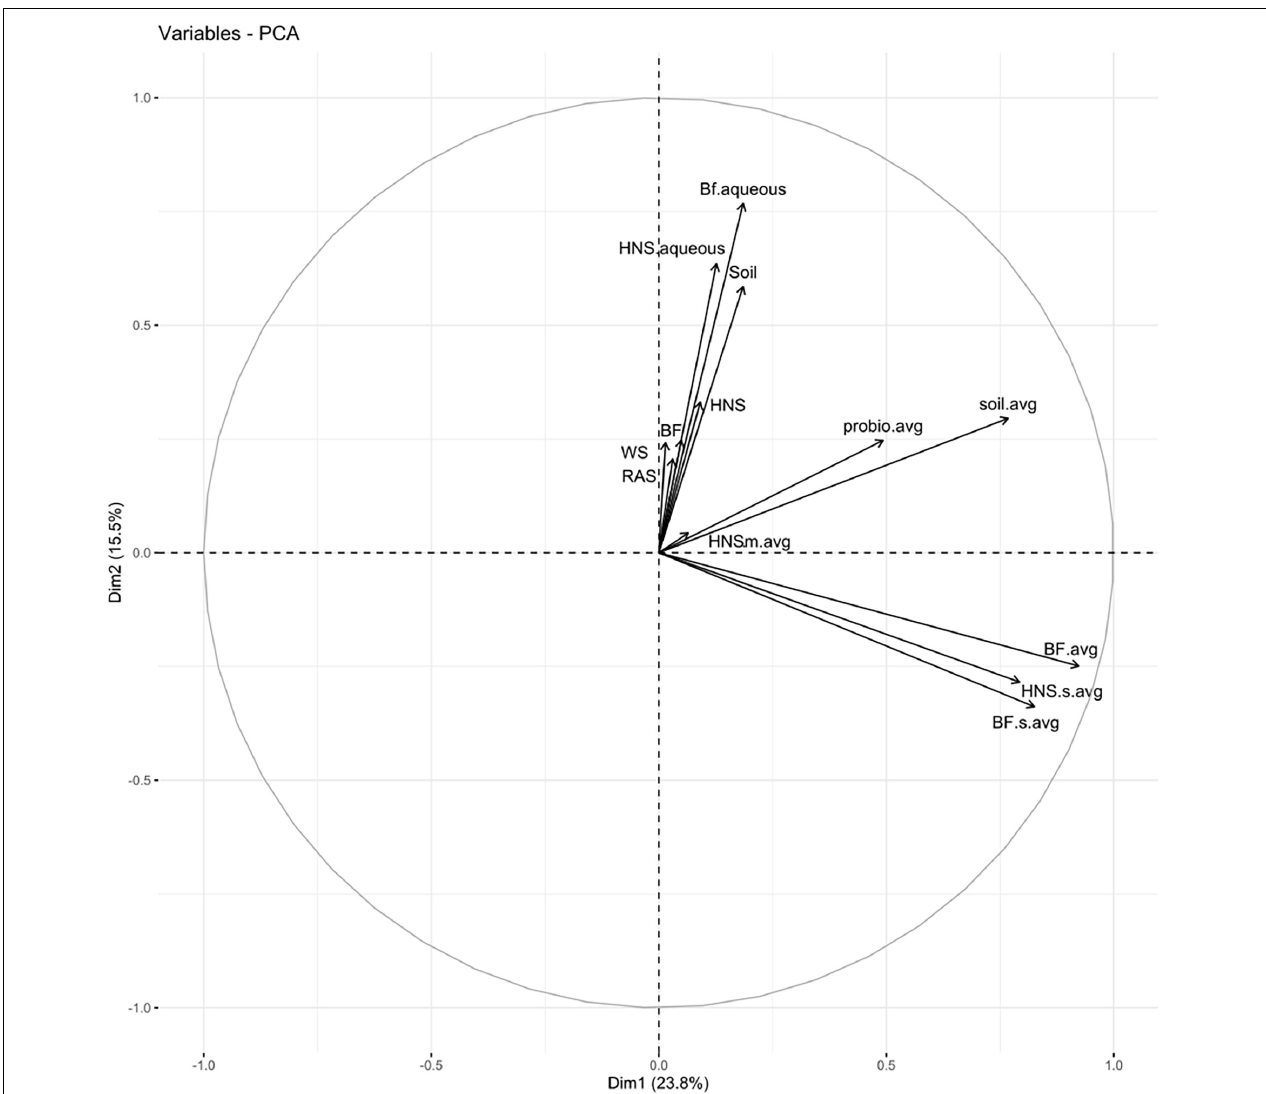
FIGURE 4 | Principle component analysis for all treatments; abundance data across technical replicates were averaged for each set. Treatments include hydroponic nutrient solution sump (HNS) and biofilter effluent sump (BF) averaged for each technical replicate and basin water column (.aqueous) conditions. Additionally, soil inoculum (Soil) and HNS inoculated culture (soil) and probiotic (probio) samples averaged for all technical replicates, as well as the facility water source (WS) and recirculating aquaculture system water column (RAS) are also